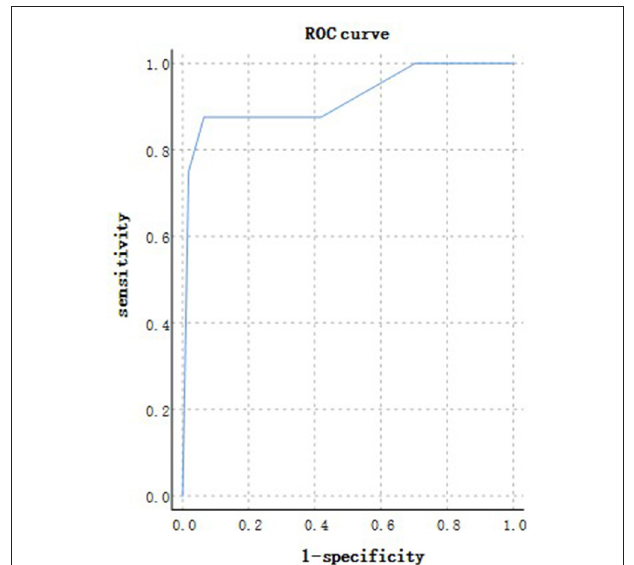
FIGURE 11 | Using age for discriminating the dead cases from the surviving patients ( n = 718; survival and dead groups, n = 710 and 8, respectively). ROC analysis showing the performance of age in distinguishing the dead cases from the surviving patients. ROC, receiver operating characteristic curve; AUC, area under the curve.